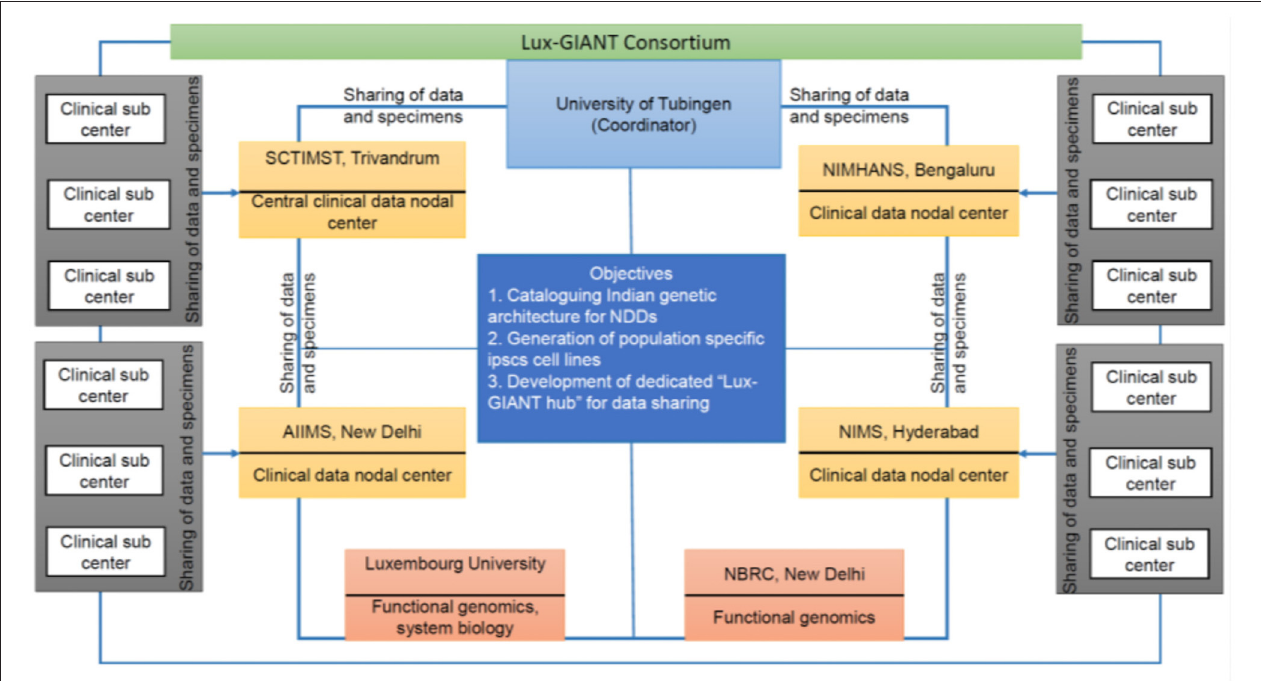
FIGURE 1 | Overall flow chart describing the details of the Lux-GIANT consortium. The consortium follows the “hub-spoke” model. The Lux-GIANT has established three main cores: genomics, clinical, and functional genomics. The University of Tubingen is the coordinator site. Luxembourg site aims to strengthen functional genomics and system biology. Functional core from India, National Brain Research Center, will be responsible for developing and maintaining iPSCs. Four main clinical-nodes capturing most of India are formed. These four nodes are connected to clinical sub-centers which span throughout India. The “central clinical node” aims to streamline the administrative process, which is required for clearance and sample shipment. The different nodes within India are connected with the main “central clinical node” for continuous update of cohort and members.